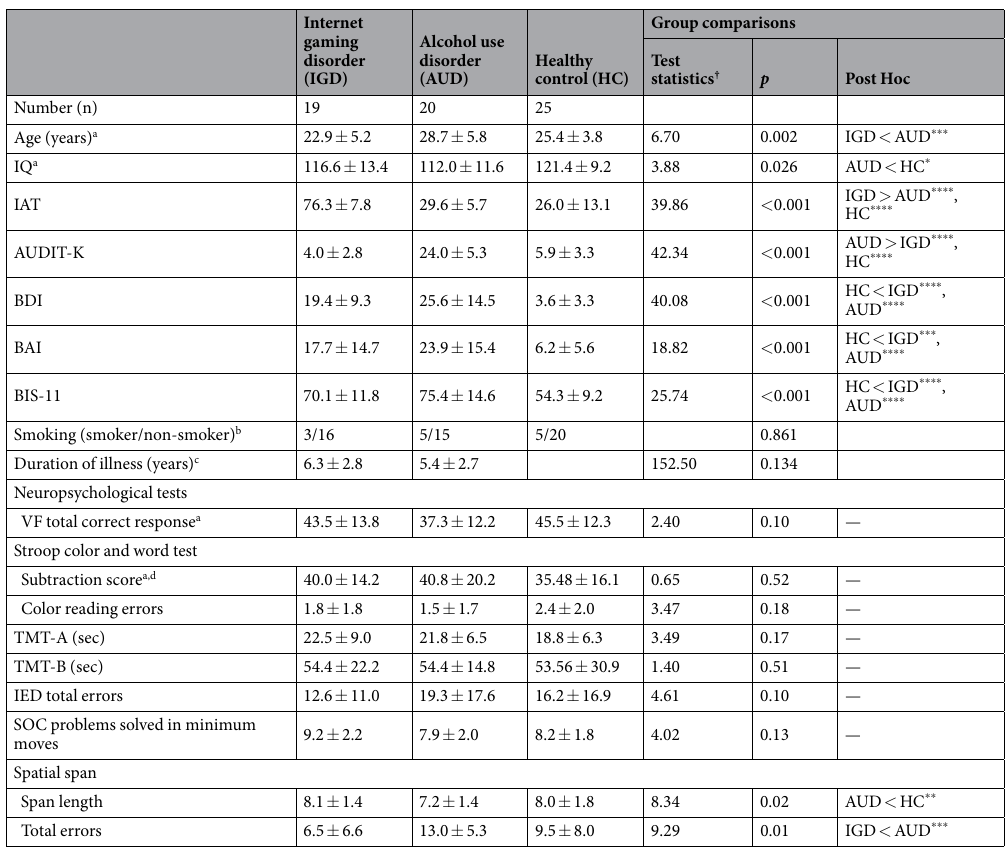
Table 1. Demographic and clinical characteristics and neuropsychological performance of participants. IQ, intelligence quotient; IAT, Young’s Internet Addiction Test; AUDIT-K, Korean version of the Alcohol Use Disorder Identification Test; BDI, Beck Depression Inventory; BAI, Beck Anxiety Inventory; BIS-11, Barratt Impulsiveness scale-11; VF, verbal fluency; TMT, Trail Making Test; IED, Intra-Extra Dimensional Set Shift; SOC, Stockings of Cambridge. † Kruskal-Wallis test was used for group comparisons with Mann-Whitney U post-hoc tests and χ 2 is reported unless a footnote appears at the name of the parameter. a One-way ANOVA was used for group comparison with Tukey’s HSD post-hoc tests and F ratio is reported. b Fisher’s exact test was used for group comparison. c Mann-Whitney U test was used for group comparison and value of U is reported. d The time for the color-word condition minus that for the word condition. * p < 0.05 ** p < 0.01 *** p < 0.005 **** p <